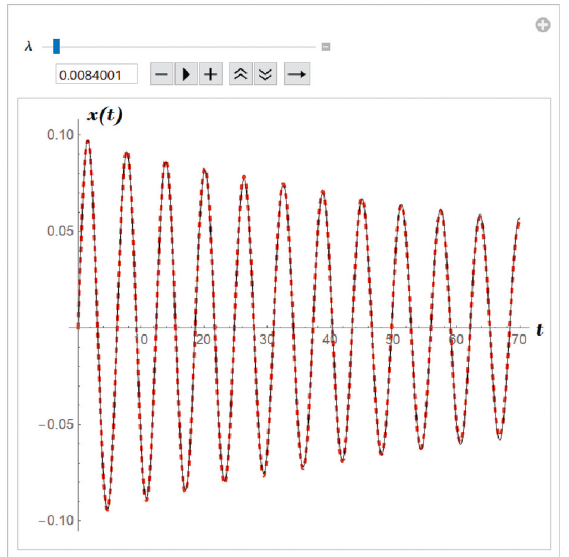
Figure 2: Comparison between analytical approximant (57) and the Runge–Kutta numerical solution for i.v.p. (56).